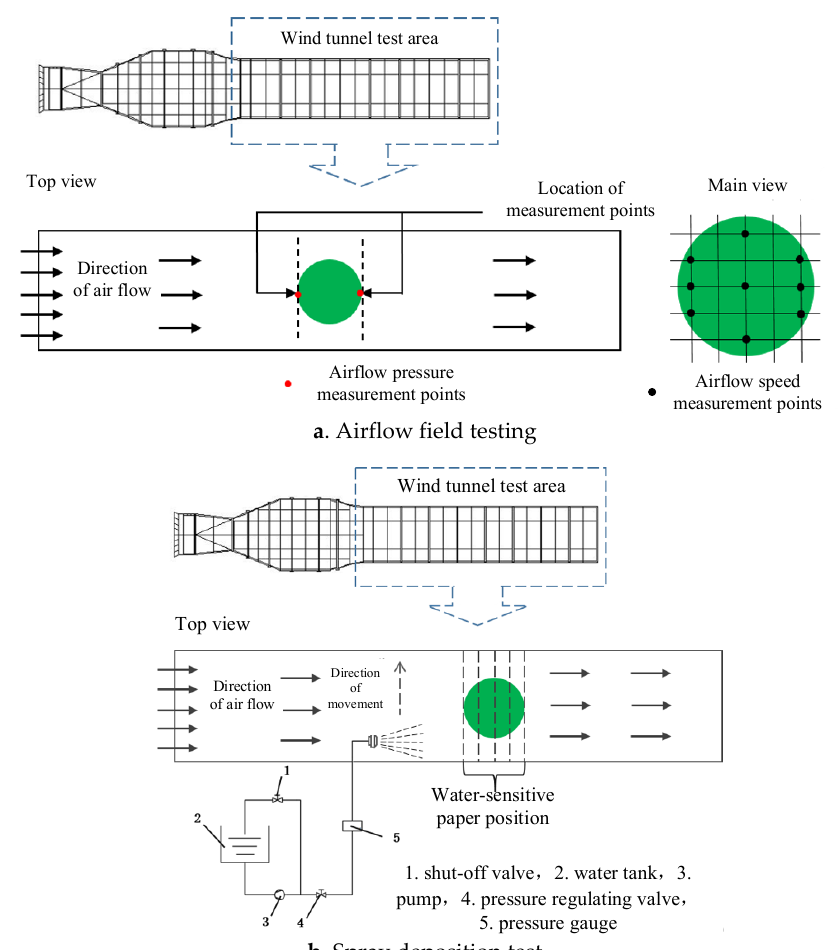
Agriculture 2023 , 13 , x FOR PEER REVIEW Figure 3. Airflow field and spray deposition test systems in the wind tunnel. Figure 3. Airflow field and spray deposition test systems in the wind tunnel.